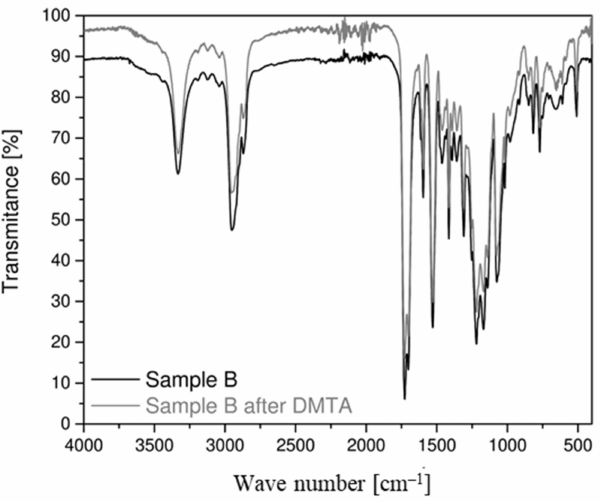
Figure 12. Comparison of the absorption spectrum for the sample B of the drive belt. DSC analysis carried out in the atmosphere of the inert gas showed the presence of a distinct endothermic effect of both materials at temperatures below 0 ◦ C, indicating the presence of a vitrification (Figure 13, Table